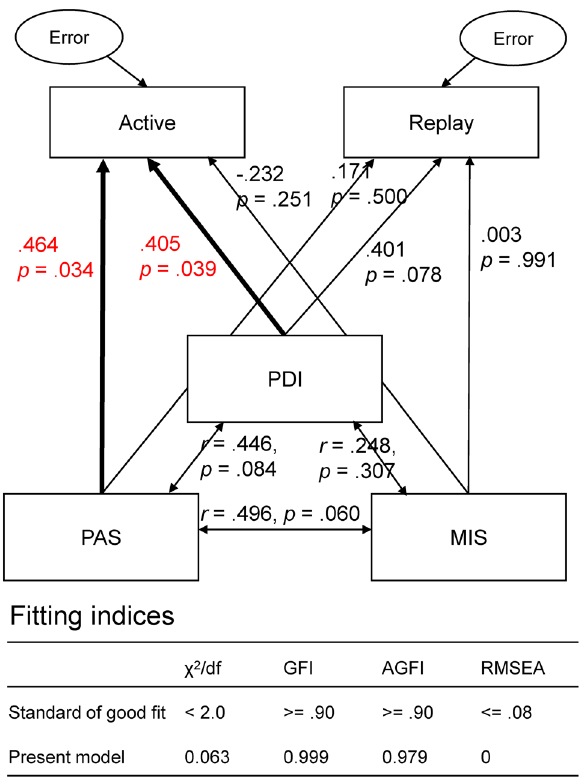
Figure 5. Standardized coefficients and significances of each path, and the fitting indices of the SEM. One-way arrows represent causal assumptions, and two-way arrows represent correlations. Significant causal paths were marked with bold arrows. The model fit the data set